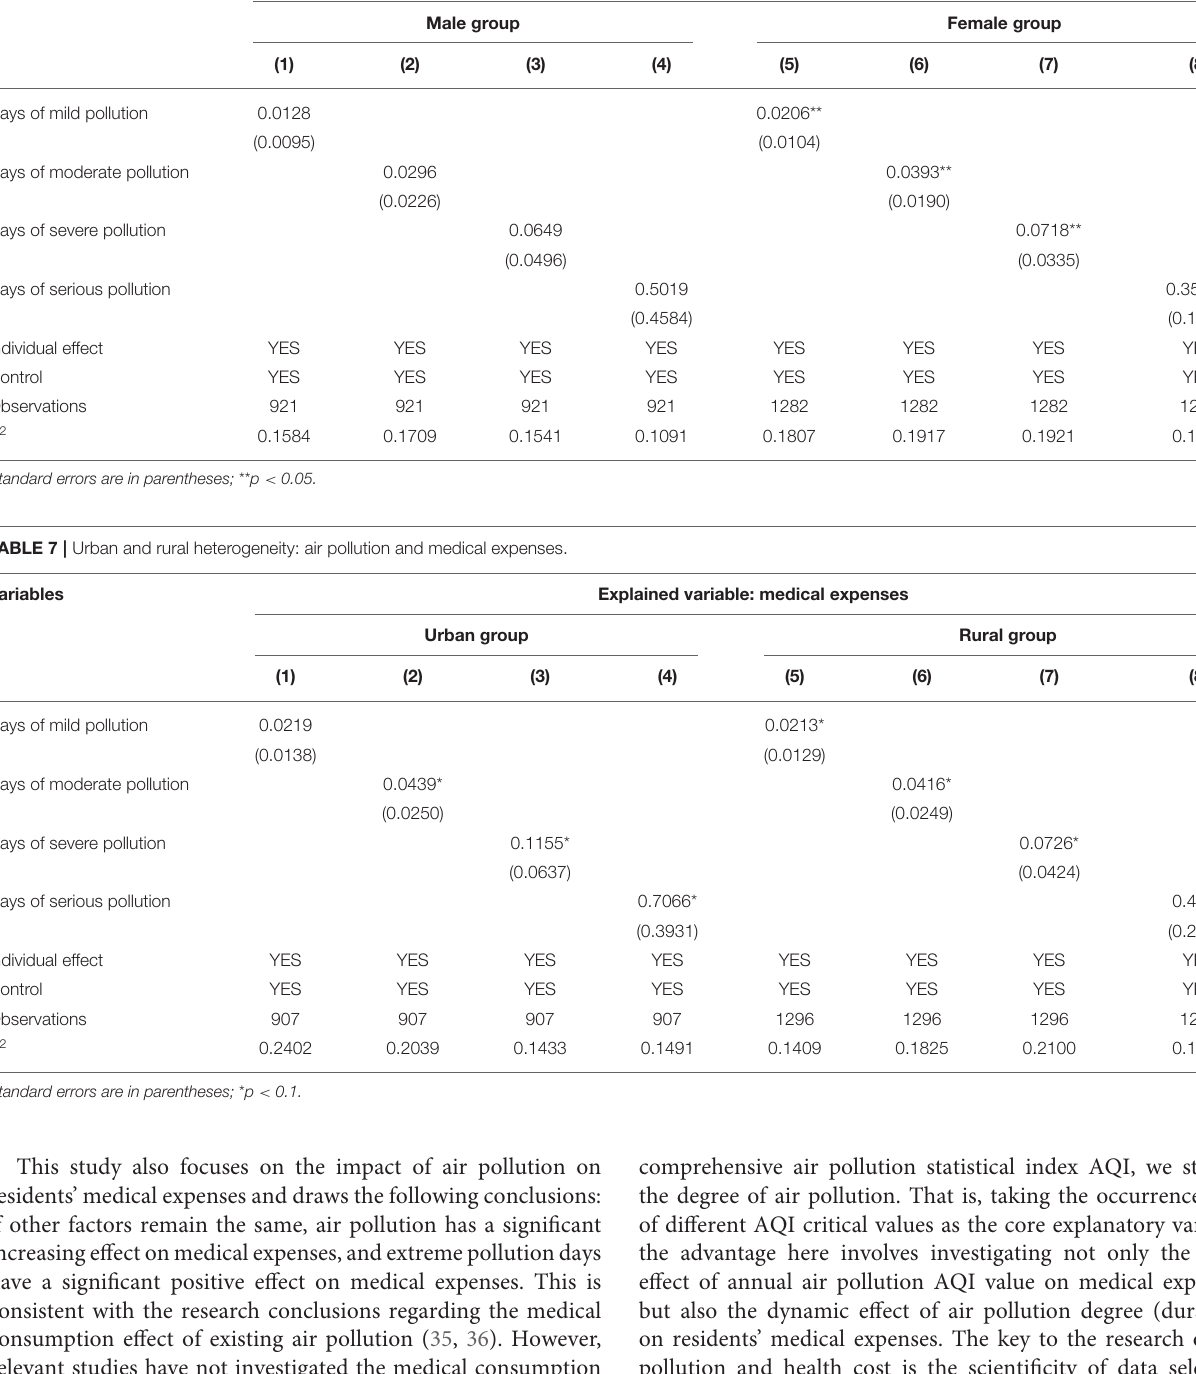
TABLE 6 | Gender heterogeneity: air pollution and residents’ medical expenses. Variables